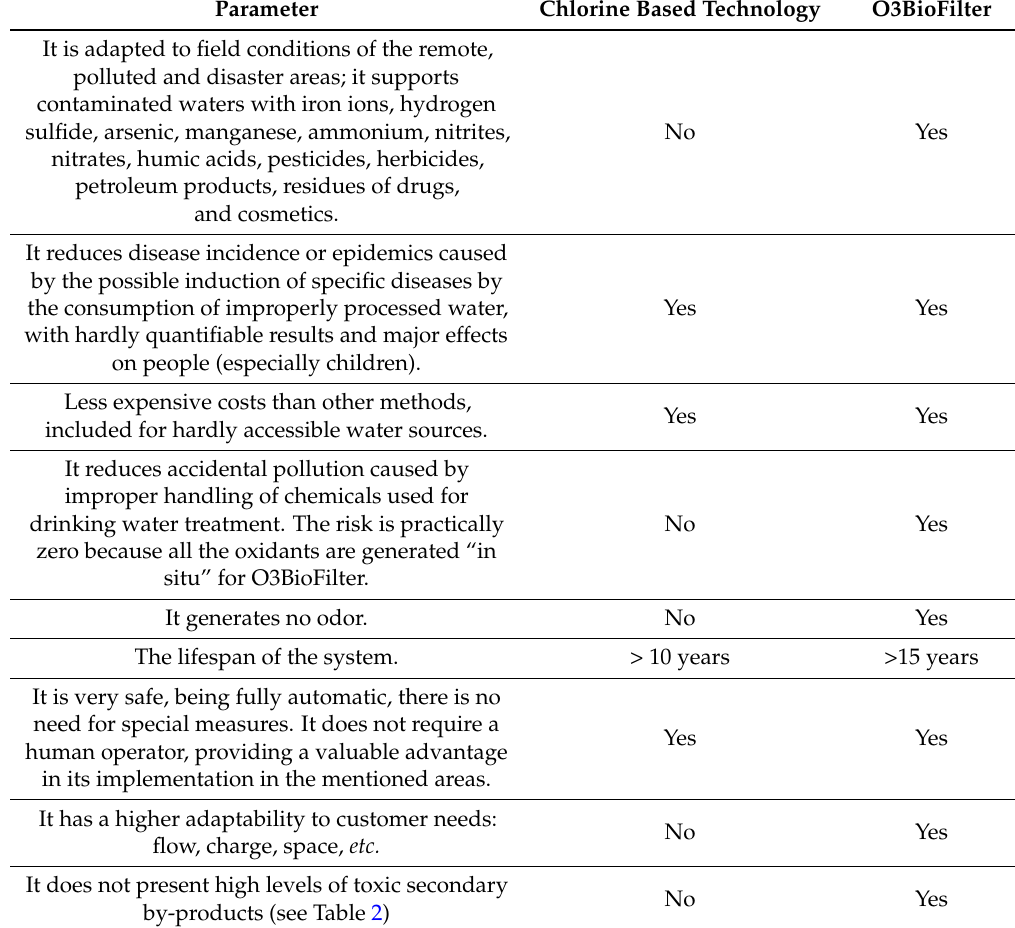
Table 1. Comparative general characteristics of chlorine and O3BioFilter drinking water stations.